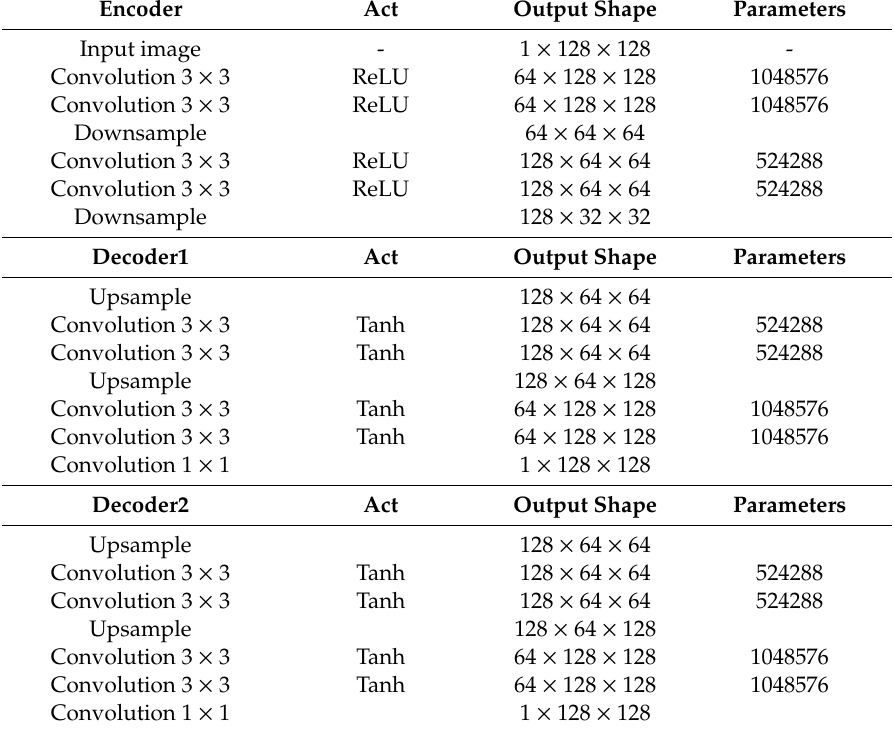
Figure 1. The structure of the convolutional dual-decoder autoencoder (CDDAE) framework. Input images are decoded to A and B , which correspond to the amplitude and phase of the exit wave. I r is the result of the image simulation when applying the contrast transfer function (CTF) to the reconstructed exit wave. Table 1. Detailed information on the convolutional dual-decoder autoencoder (CDDAE) network. Encoder Act Output